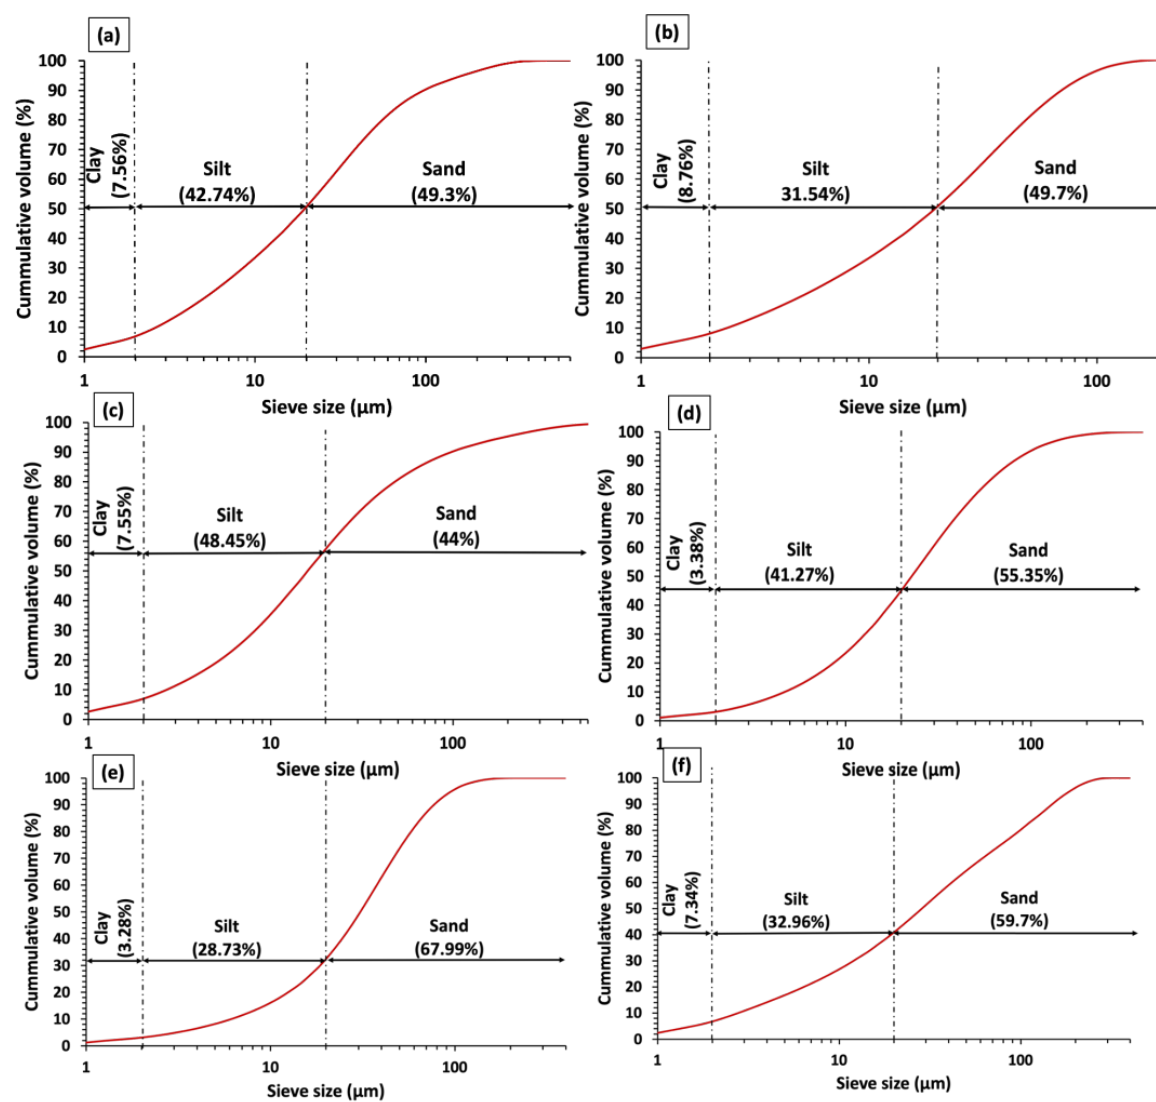
Figure 10. Particle size distribution of ( a ): Clay I, ( b ): Clay II, ( c ): Clay III, ( d ): Clay IV, ( e ): Clay V, ( f ): Clay VI.